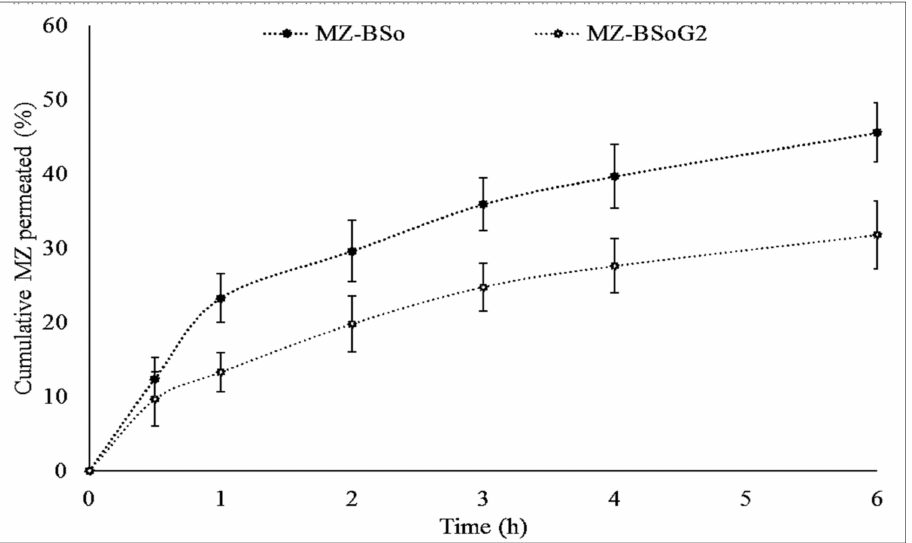
Figure 5. Comparative permeation study of miconazole bilosomes (MZBSos) and miconazole bilo- some gel (MZBSoG2). Study performed in triplicate, and data shown as mean ± SD. Statistical study compared between each